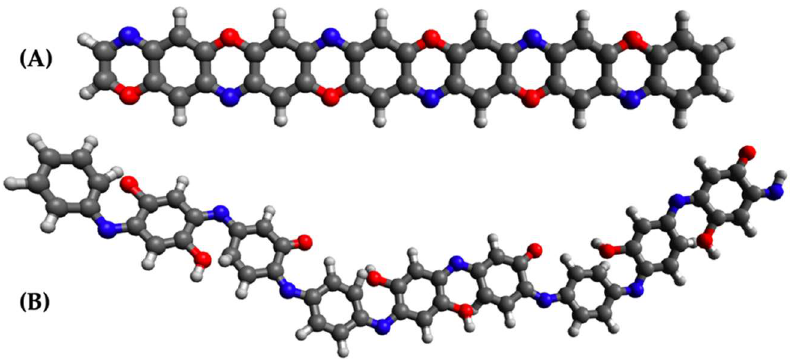
Figure 2. Trimer ( A ) quinoid and ( B ) keto oAP molecular structures, which were subjected to optimization by energy minimization at the DFT/B3LYP/6-31G(d) level of theory. Structures were visualized with Avogadro [22] GUI software.